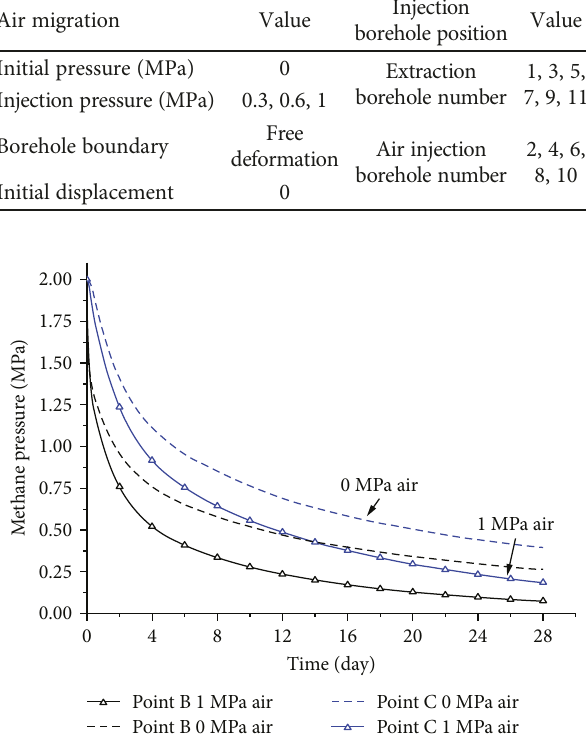
Figure 10: Methane pressure changes with time during air injection.